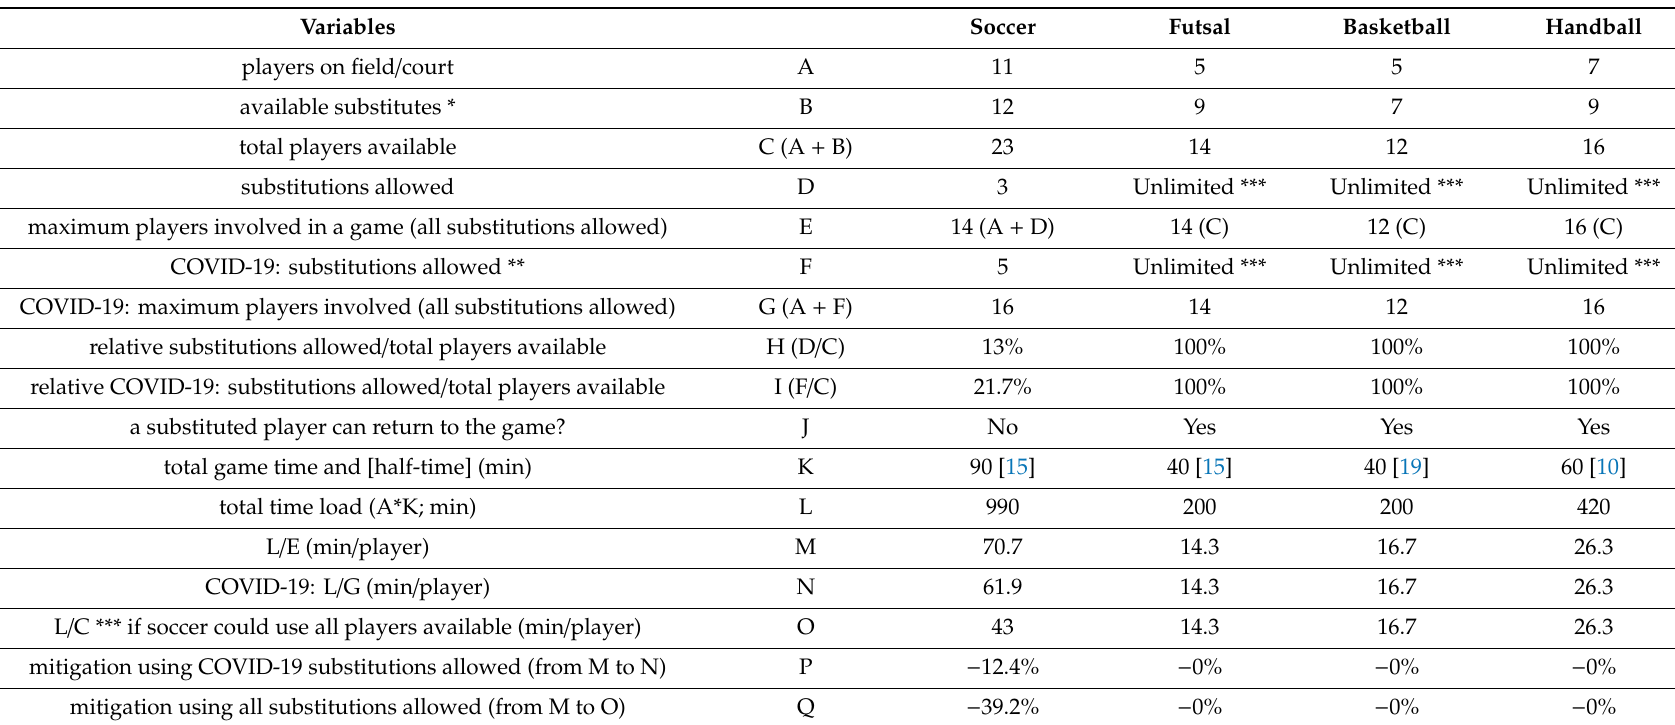
Table 1. Description of the rules and mathematical outcomes obtained of each team sport, focusing on the substitutions. Variables Soccer Futsal Basketball Handball players on field / court A 11 5 5 7 available substitutes * B 12 9 7 9 C (A + B) 23 14 12